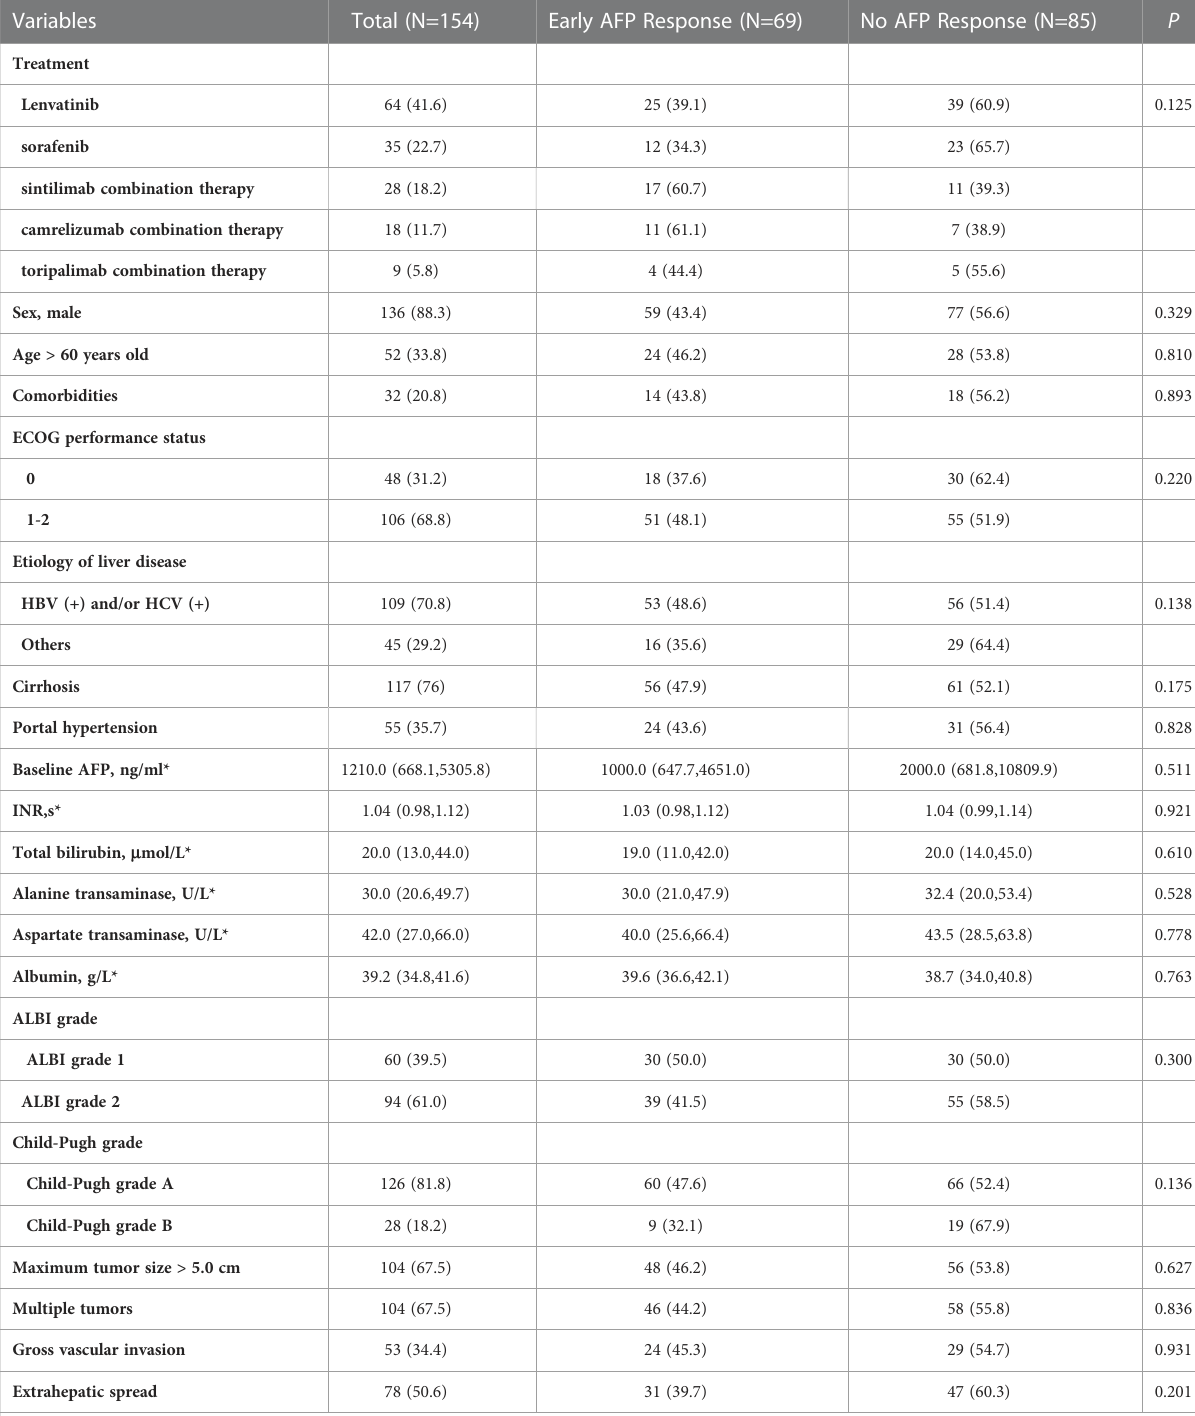
TABLE 1 Comparisons of the patients ’ baseline